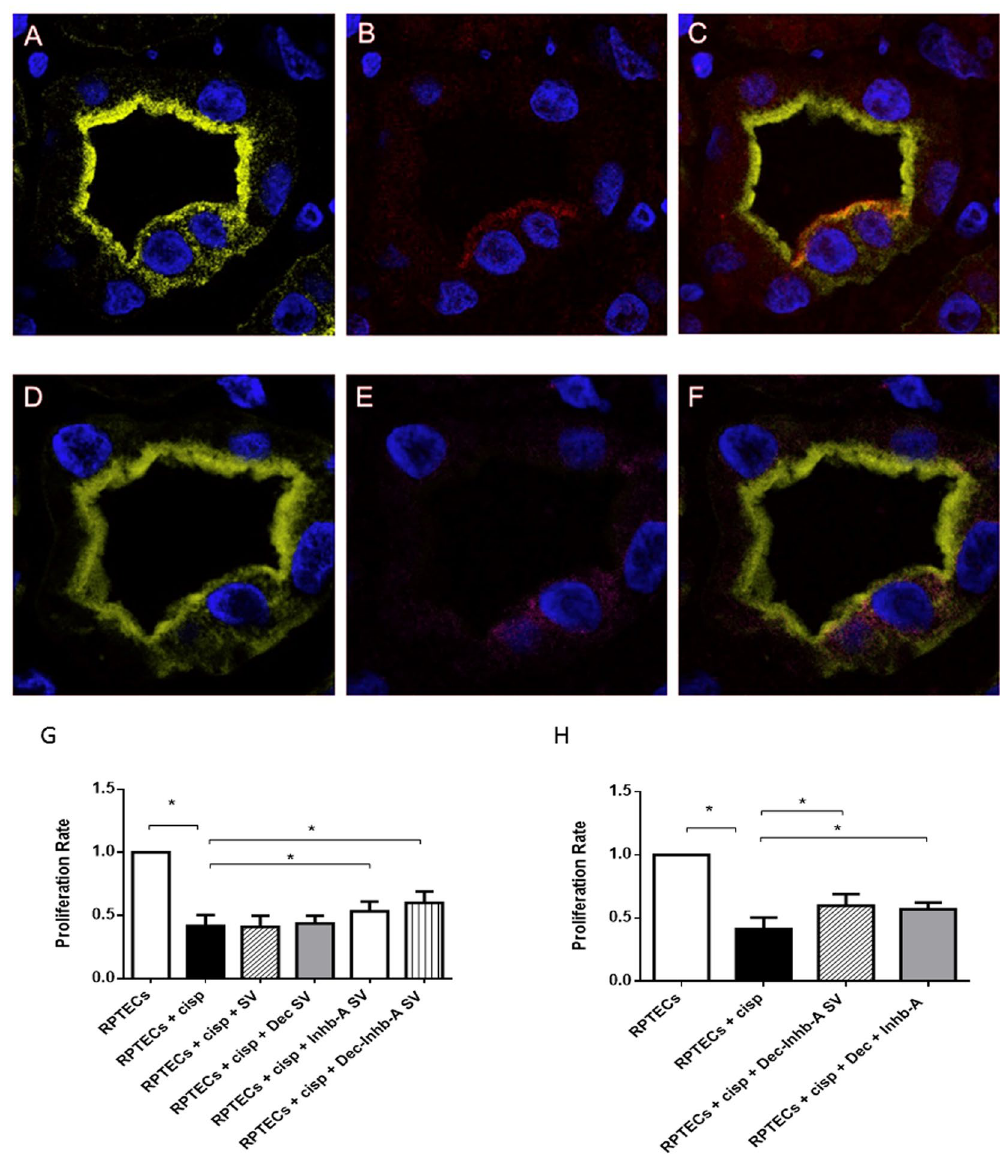
Figure 7. Inhibin-A is expressed by damaged renal tubules that enclosed tARPCs and its exogenous administration increased damaged-RPTEC proliferation rate. ( A – F ) Immunofluorescence on seriate tissue sections showed a proximal tubule labeled with Lotus (green, A , D ) in which there are two CD133 + progenitor cells (red, B ) co-expressing Inhb-A (magenta, E ). ( C ) Overlay of CD133 (red, C ) and lotus ( A ). ( F ) Overlay of Inhb-A (magenta, ( E ) and lotus ( D ). The expression of Inhb-A colocalized with CD133 + progenitor cells. To-pro-3 counterstained nuclei (blue). Original view: × 63. Reprinted from [Kidney International] 46 , Supplementary Figure S7, Copyright (2013), with permission from Elsevier. ( G , H ) BrdU proliferation assays showing that exogenous administration of Inhb-A and decorin increased damaged-RPTEC proliferation rate. ( G ) Inhb-A and decorin were loaded, individually or together, within polysaccharide synthetic vesicles (SV). The addition of Inhb-A and DCN SV to cisplatin-treated RPTECs led to a substantial increase in cell proliferation after 3 days of culture. DCN-SV alone were not able to increase the RPTEC proliferation rate, whereas INHB-A-SV gave a significant increase. On the other hand, the SV loaded with DCN and Inhb-A together gave a higher increase of cell proliferation. ( H ) BrdU proliferation assays showed that the exogenous administration of Inhb-A and decorin in the medium increased cell proliferation as proteins included in